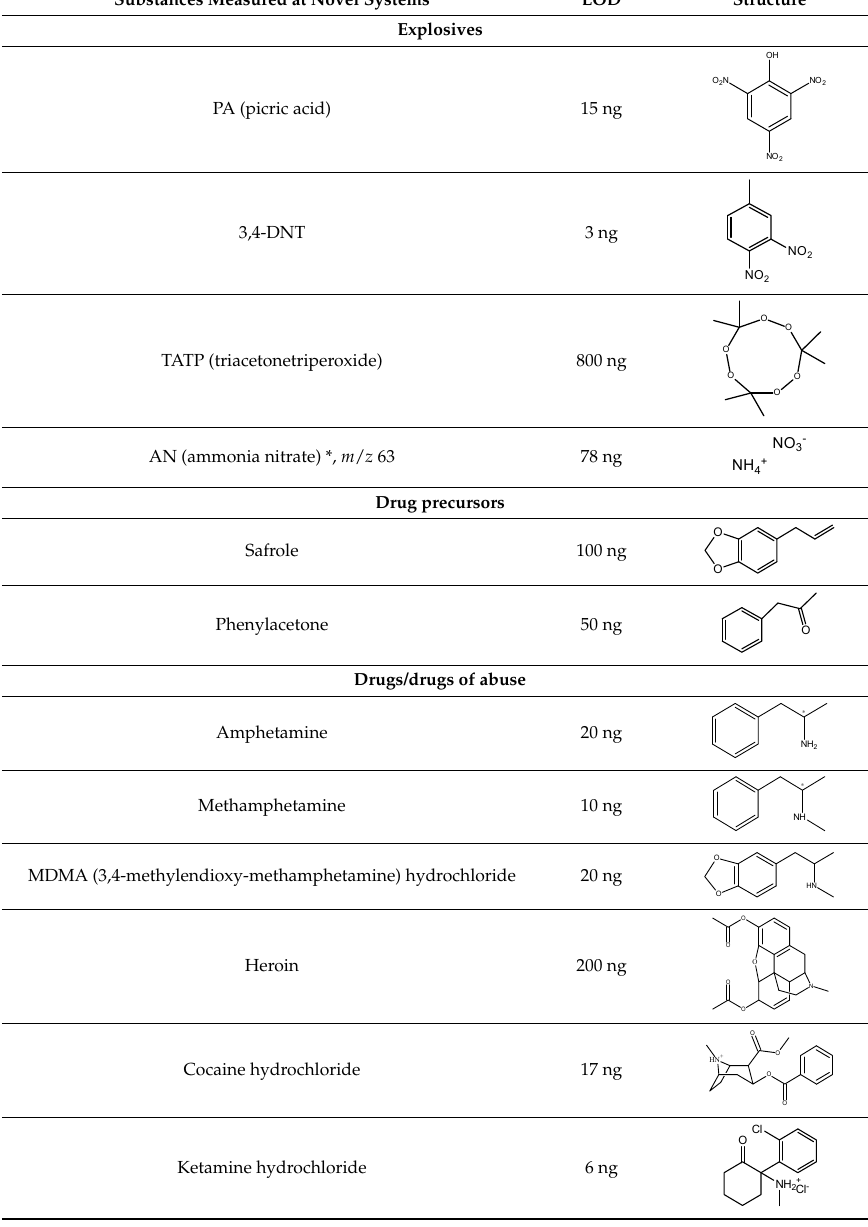
Table 2. Limit of detection for different individually determined drug precursors, drugs, drugs of abuse, and some additional explosives measured with the novel APLD system. It is mutually assumed that the amount of substance is to be seen as a total amount and the sample spot is considered as totally desorbed at the measurement as described in the materials and methods section. Substances that have been detected as fragments are marked with an * along with the m / z fragment value. All explosives were detected as molecular ion signals and all other substances as protonated molecular ions. All explosives were measured in negative detection mode, all other substances in positive detection mode.